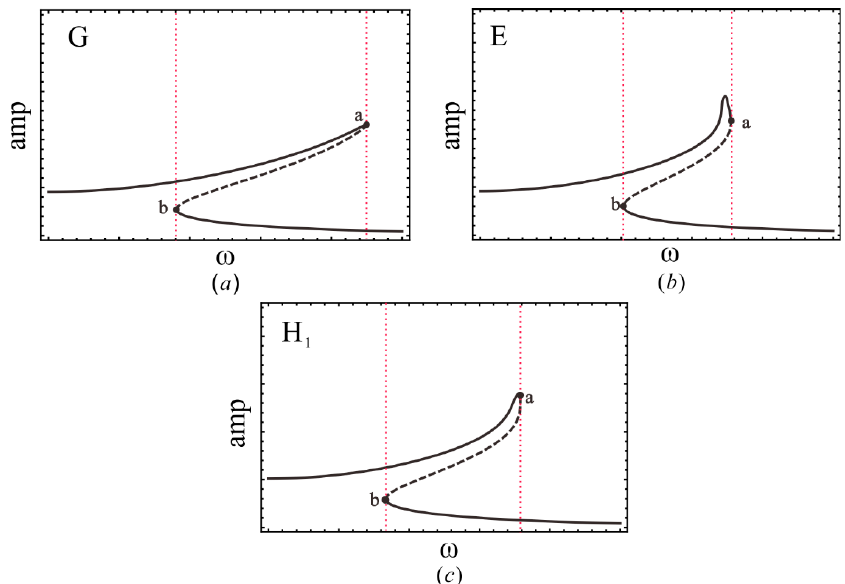
Figure 7. Amplitude ‐ frequency response curve in ( a ) region G ; ( b ) region E; and ( c ) line H 1 , where the solid points a, b are tangent points.